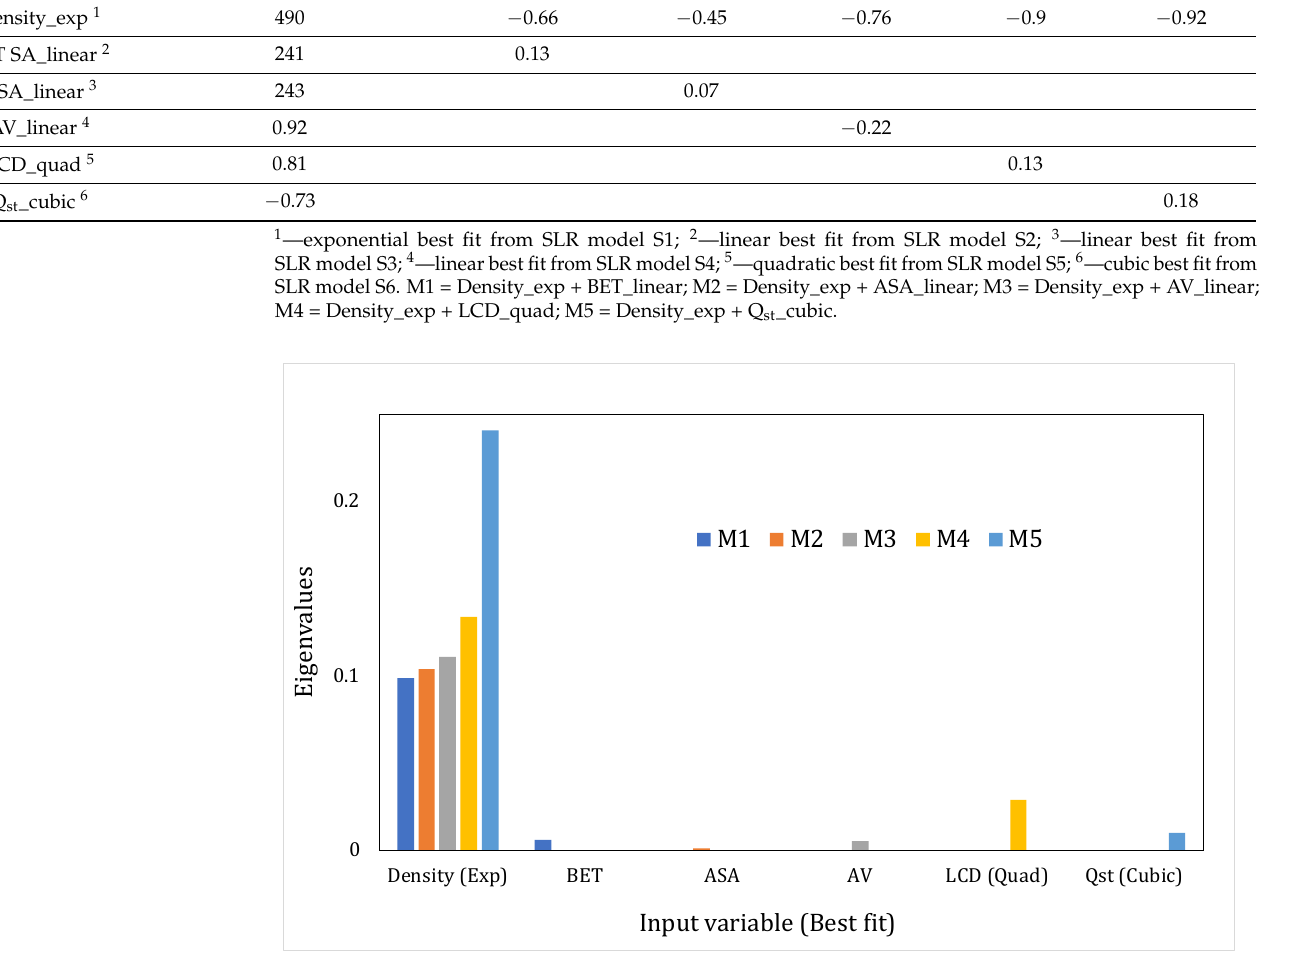
Figure 5. Eigenvalues for the 2 dimensions in 5 MLR models corresponding to the best-fit model of each input variable that was obtained from the SLR analysis.